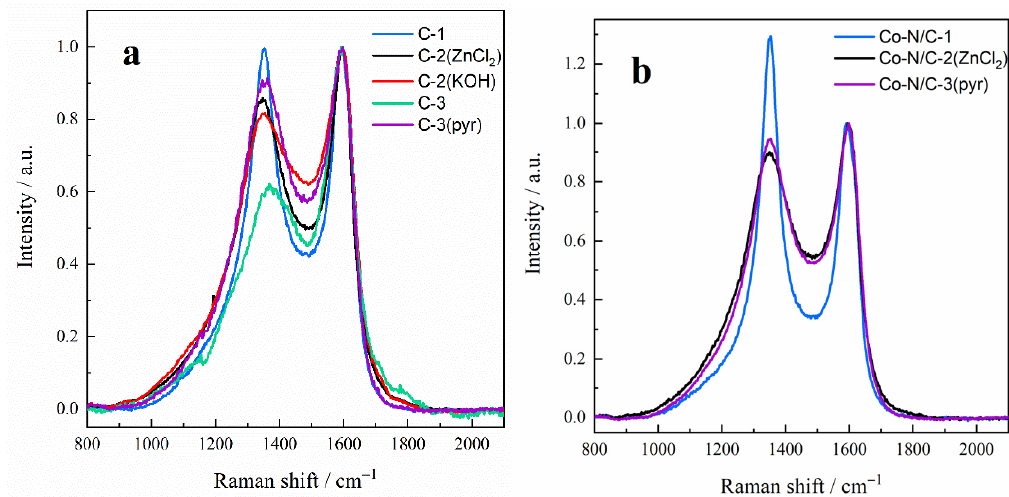
Figure 7. Raman spectra for PDC ( a ) and selected Co-N/PDC ( b ) materials (noted in Figure). Table 4. Raman spectroscopy analysis